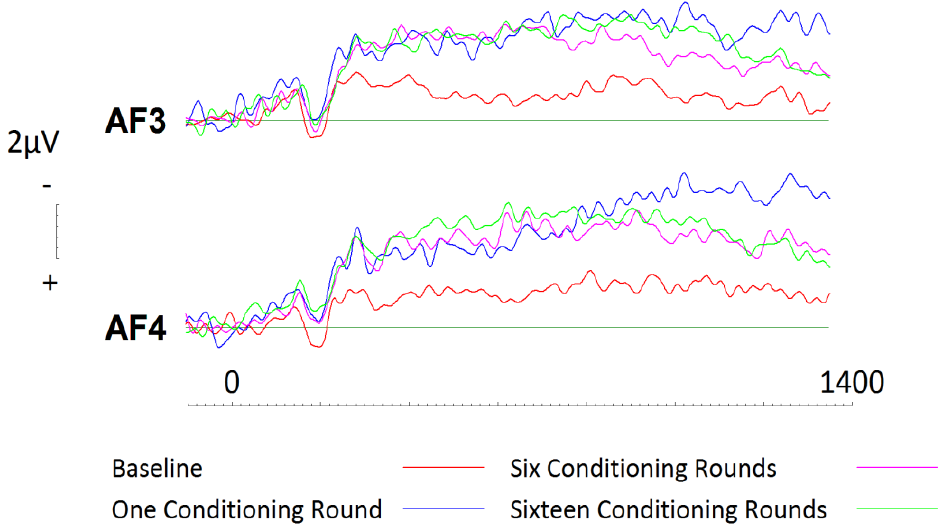
Figure 7. ERPs generated during each conditioning round for disliked brands across frontal electrode sites AF3 and AF4. Significant increases in activity were observed between session one and subsequent sessions as brands were conditioned more positively.